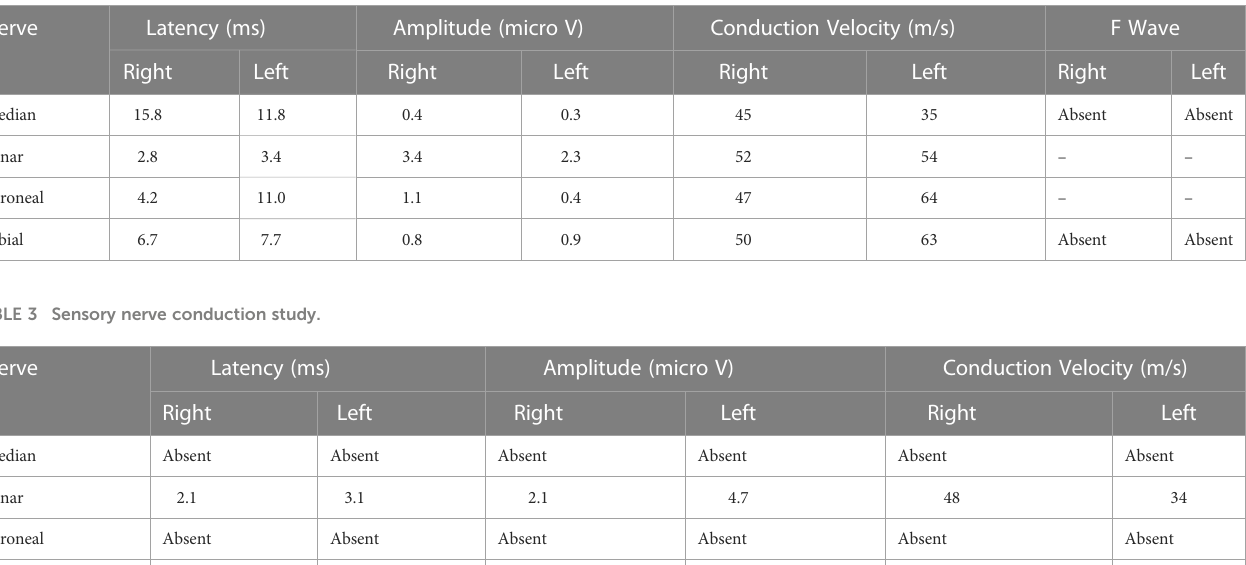
TABLE 2 Motor nerve conduction